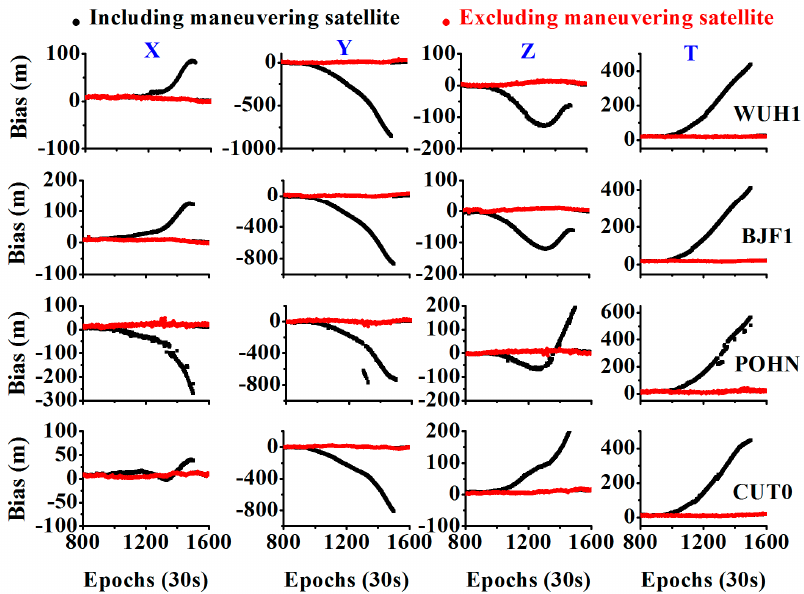
Figure 11. Comparison between the SPP results when including the maneuvering satellite and excluding the maneuvering satellite.